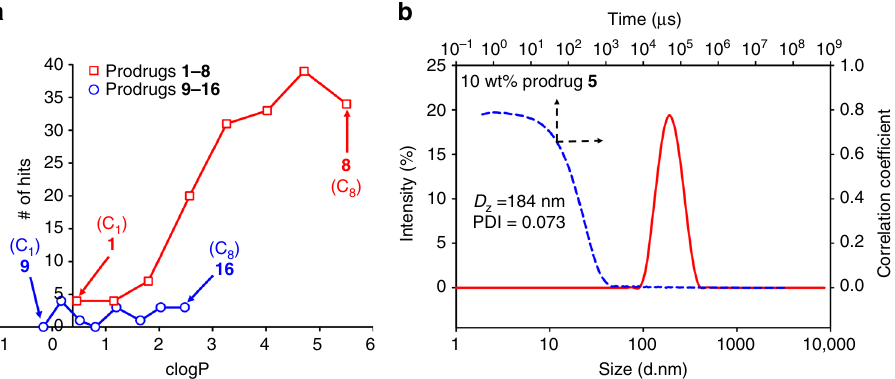
Fig. 3 Success of emulsion-templated freeze drying screening to form semi-solid prodrug nanoparticles (SSPNs). a Relationship between calculated log P (clog P ) and number of hits identi fi ed at 10 wt% prodrug loading relative to water-soluble excipients for each prodrug candidate, and b dynamic light scattering of a representative SSPN dispersion in water (1 mg mL − 1 ; 10 wt% prodrug 5 , 60 wt% PVP K30, 30 wt% Tween